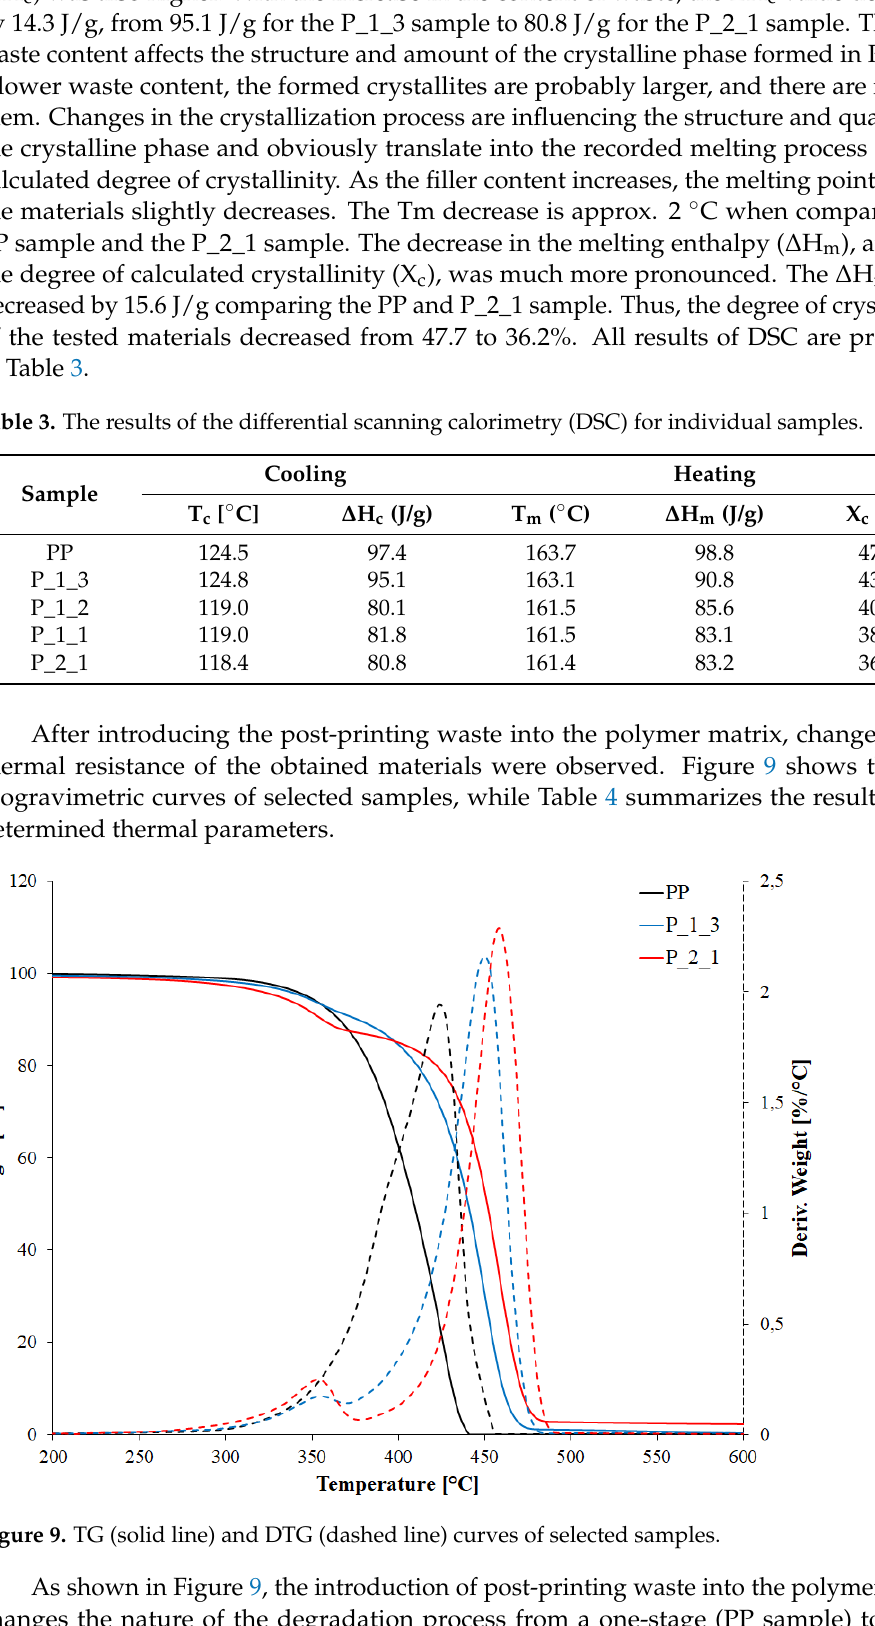
Table 3. The results of the differential scanning calorimetry (DSC) for individual samples.